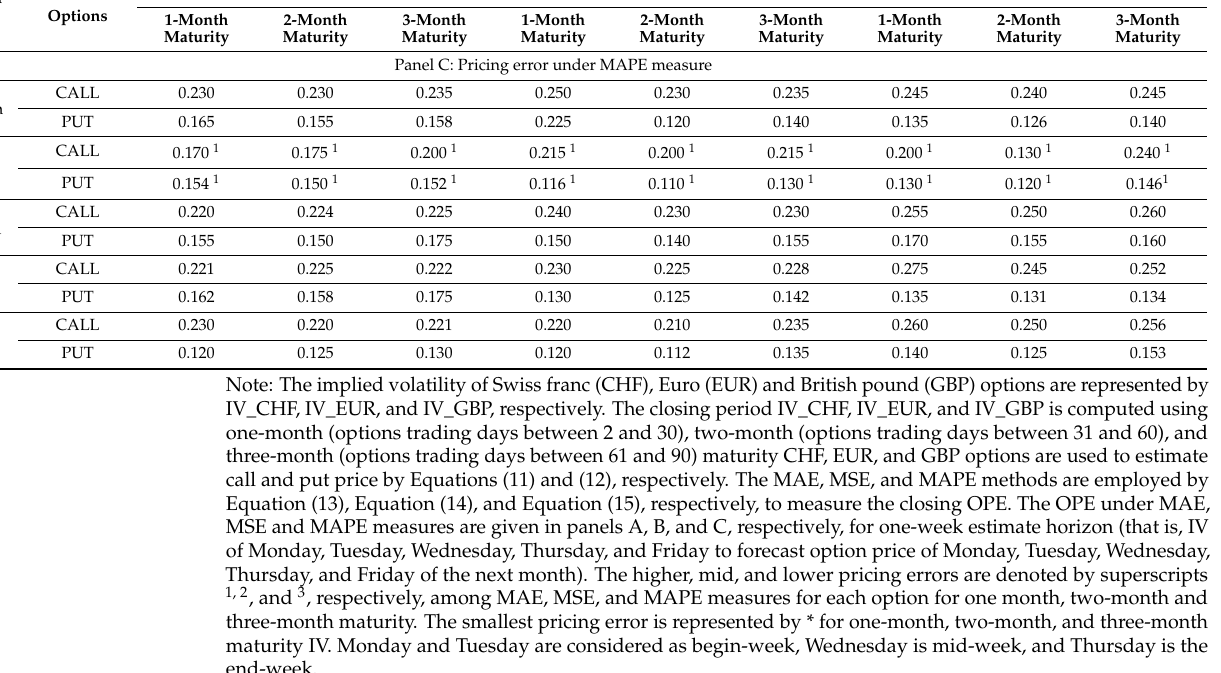
Panel C: Pricing error under MAPE